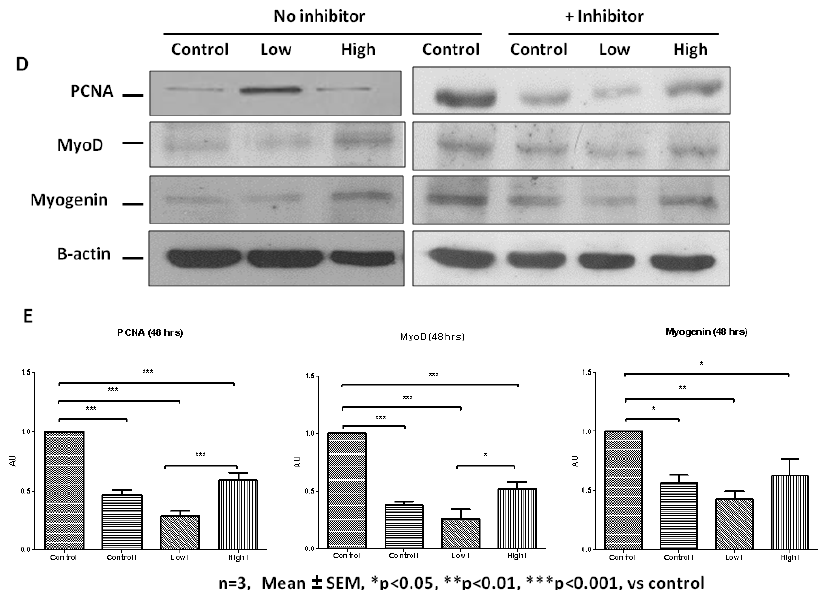
Figure 5. IL-6 activates the STAT3 signaling pathway in C2C12 cells. ( A ) Evaluation of p-STAT3 protein levels in C2C12 cells at 5 min up to 30 min after treatment of cells with low, medium and high IL-6 concentrations. ( B ) Quantification of western blot images shown in ( A ) . ( C ) Effect of JAK-STAT inhibitor, AG490, on p-STAT3 expression in C2C12 cells over 15 min after treatment with low and high IL-6 concentration. ( D ) Effect of JAK-STAT inhibitor, AG490, on PCNA, MyoD and myogenin protein levels in C2C12 cells after treatment with low and high IL-6 concentrations (top panel) and densitometric quantification of images (lower panel) ( E ) Quantification of PCNA, MyoD and myogenin protein levels in C2C12 cells after treatment with low and high IL-6 concentrations plus JAK-STAT inhibitor, AG490. The experiment was repeated three times. Immunofluorescence images were taken at 100 × magnification. Results are presented as mean ± standard error of the mean (S.E.M). Statistical analysis: ANOVA and Bonferroni post hoc test. * p < 0.05; ** p < 0.01; *** p < 0.001.